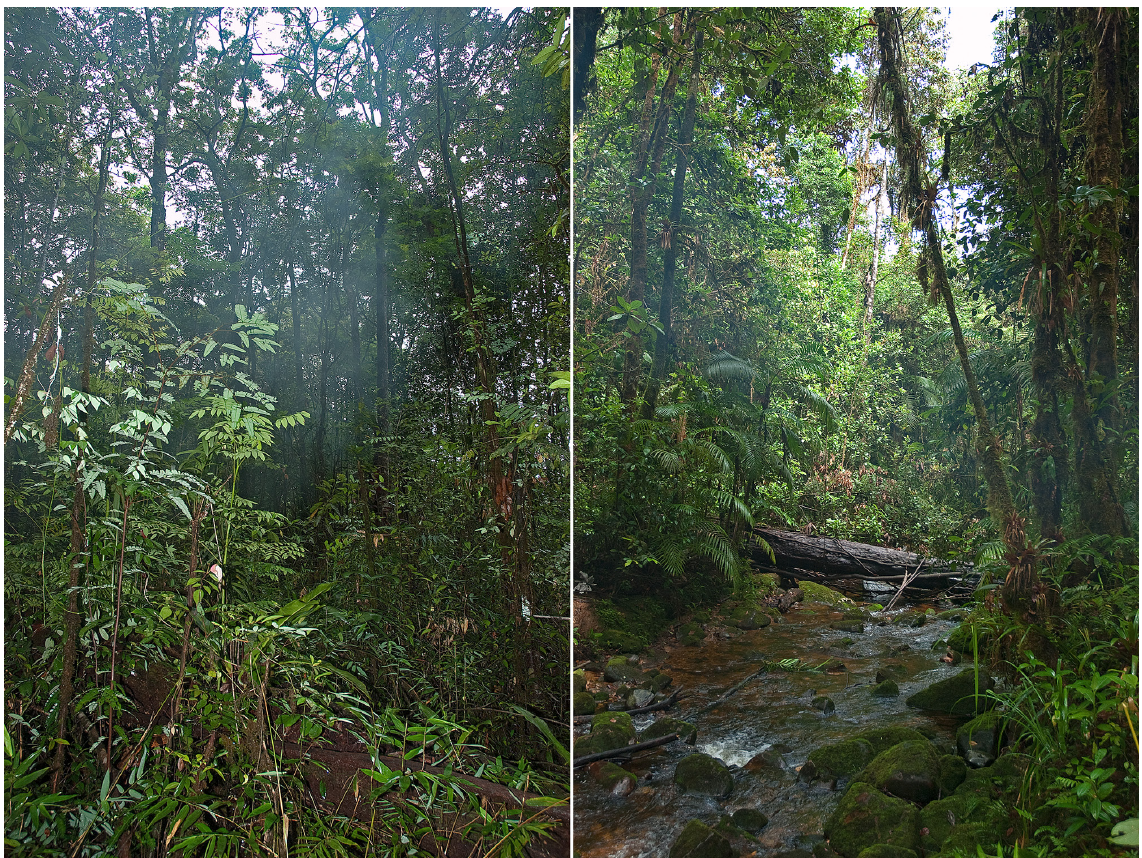
Fig. 9. Habitat of Pristimantis marmoratus (Boulenger, 1900). Left . Submontane rainforest in Kaieteur National Park at ca 630 m elevation. Right . Montane rainforest on the slopes of Maringma-tepui, Guyana at ca 1376 m elevation. Photographs by